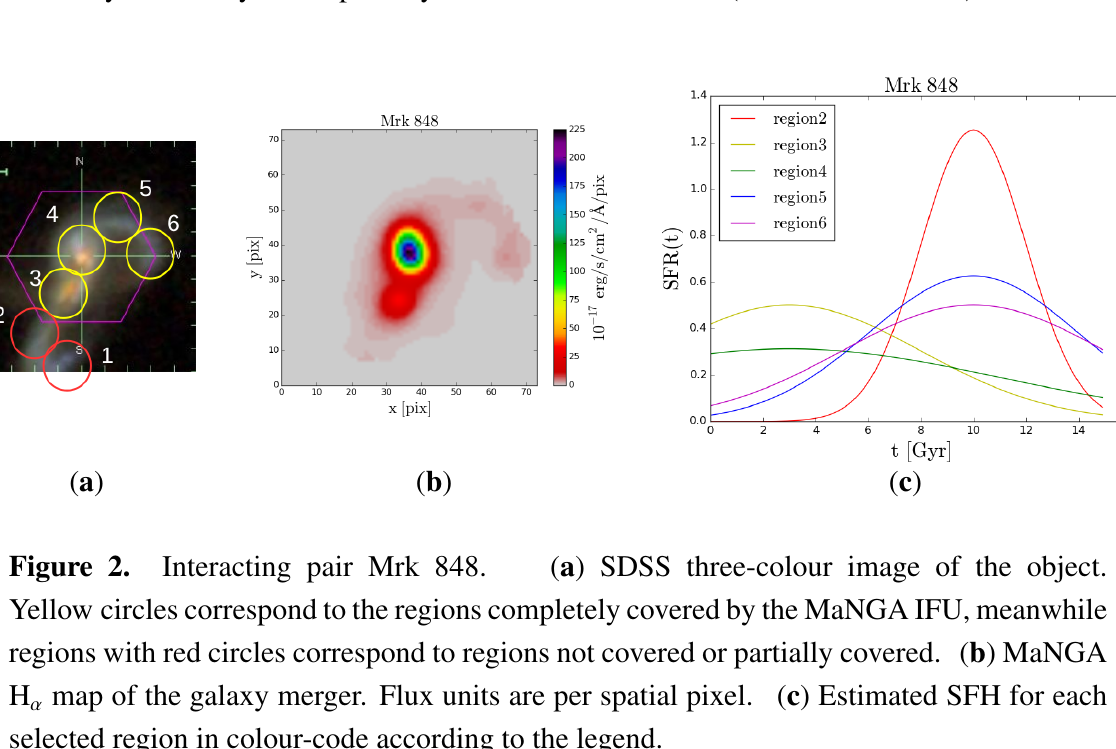
Figure 1. Isolated galaxy SIG 2246. ( a ) SDSS three-colour image of the galaxy and the corresponding MaNGA IFU field of view; ( b ) MaNGA H map of the galaxy and the α considered elliptical annuli bins. Flux units are per spatial pixel; ( c ) SFH for each radial bin, normalised to the IFU radii. Error bar in the Y-axis corresponds to the σ of the Gaussian distribution in each radial bin. Error bar in the X-axis corresponds to radial bin length, manually divided by 3 to separately visualise each error bar (not as a continuum).